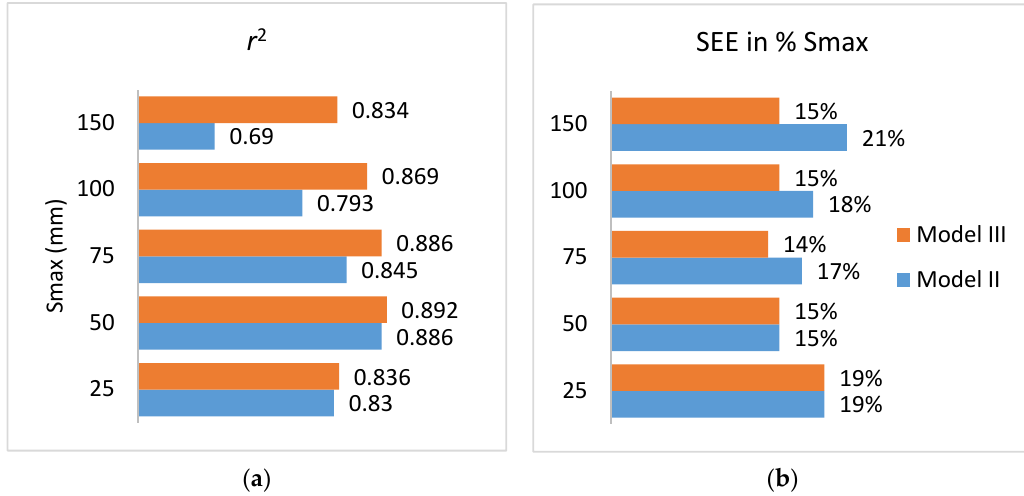
Figure 9. Model performance in the range of the Smax’s tested, comparing the logistic model (II) with the segregated model (III): ( a ) determination coefficient ( r 2 ) and ( b ) standard error of the estimate (SEE, %Smax).